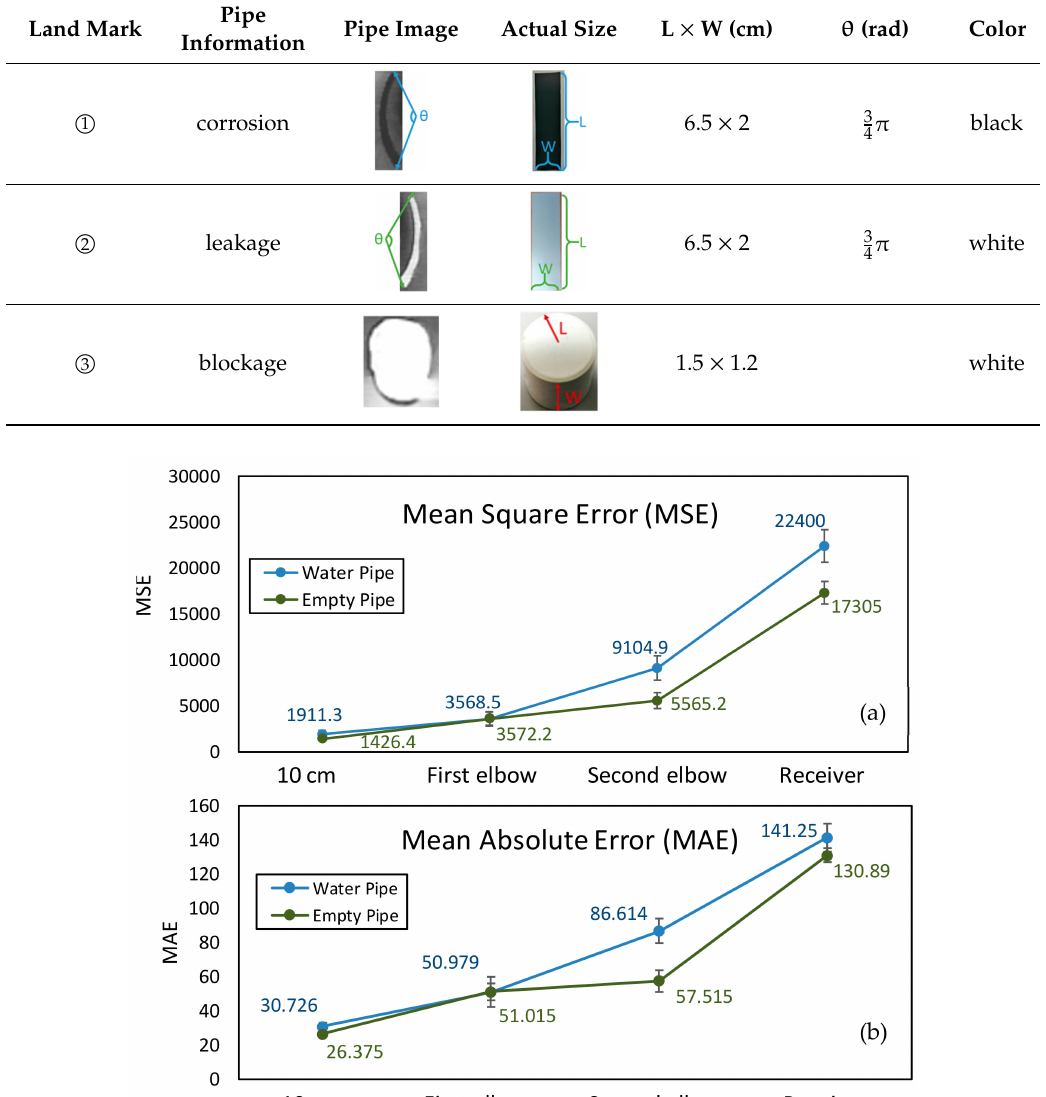
Table 1. The characteristics of landmarks in the pipe.